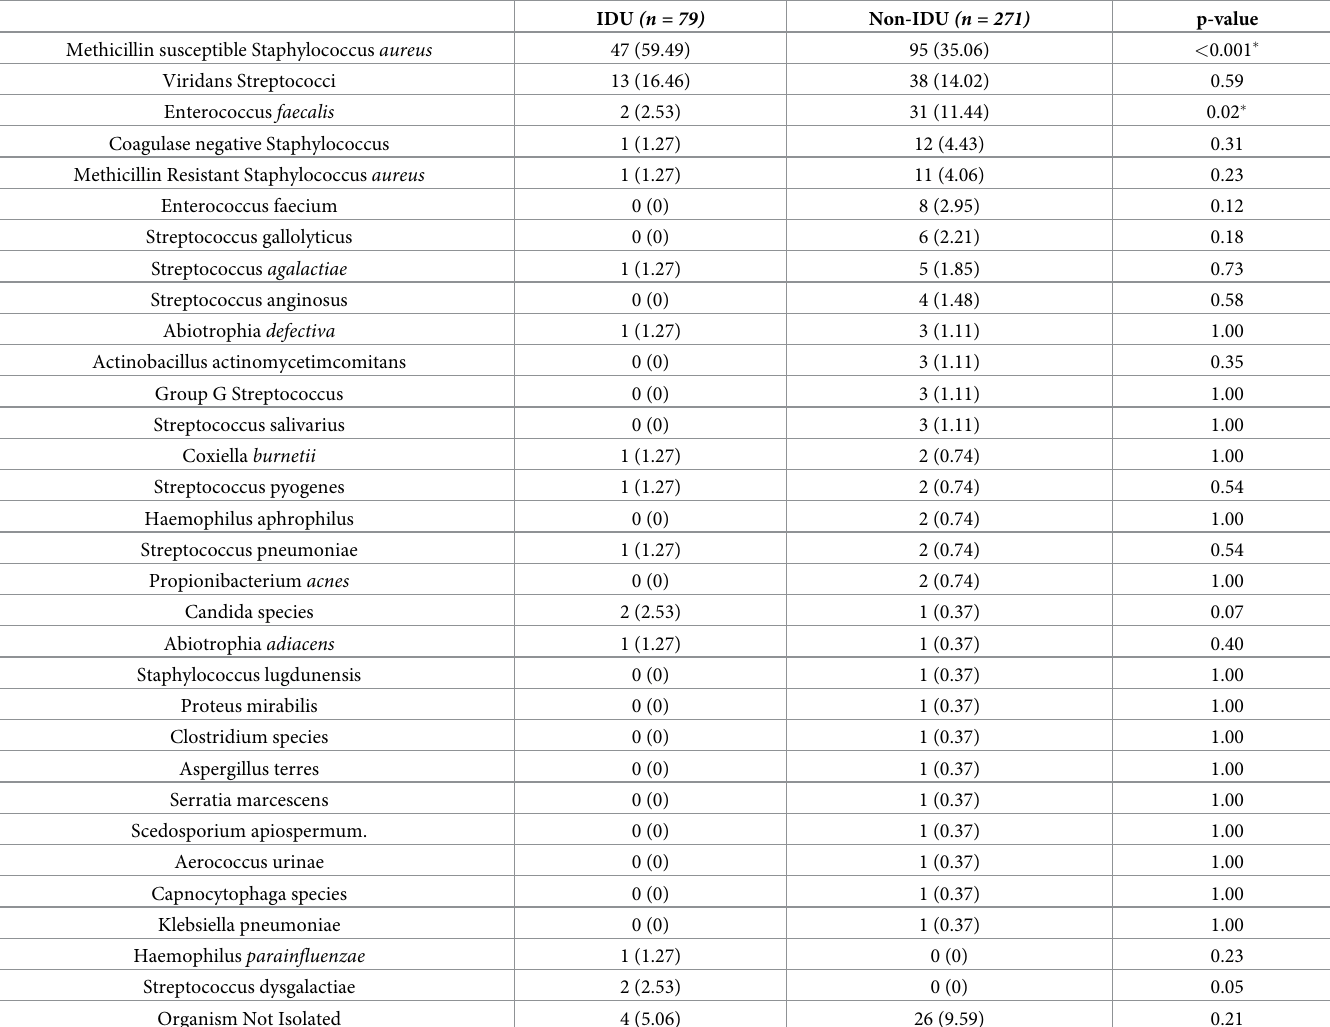
Table 3. Aetiological organism. All characteristics have been displayed as total number with percentage proportion in brackets. Statistical significance was determined using chi-square test for categorical variables with a sample size over five and Fisher’s exact test for categorical variables with a sample size equal to or less than